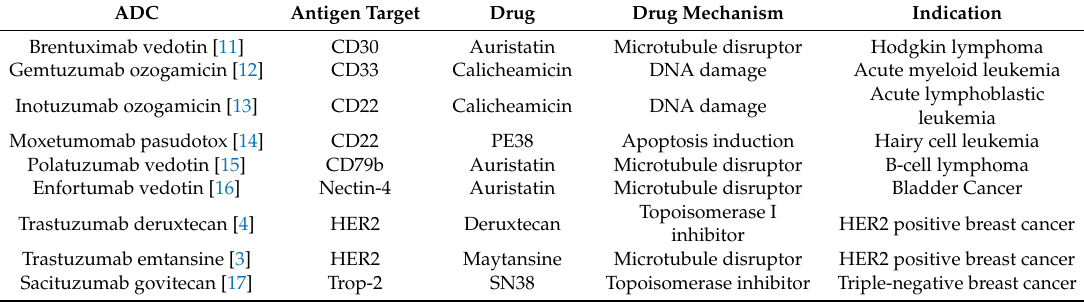
Table 1. Summary of the currently FDA approved antibody-drug conjugates (ADC), including their cellular targets, drug and drug mechanisms, and